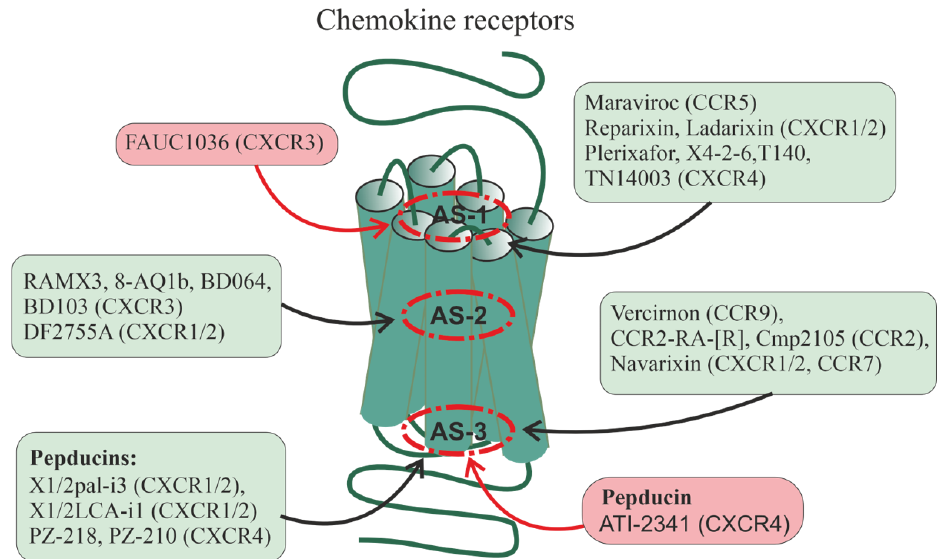
Figure 2. Allosteric regulation of chemokine receptors. There are data on the allosteric regulation of a significant number of chemokine receptors, including CXCR1, CXCR2, CXCR3, CXCR4, CCR2, CCR5, CCR7, and CCR9. Allosteric sites in them can be located at different loci of the TMD: in the upper (outwardly oriented) portion of the transmembrane tunnel (interfaces including the membrane- proximal segments of ECLs and extracellular segments of TMs, as well as the outer vestibule of the transmembrane channel) (designated as AS-1), in the central part of the 7TM bundle (AS-2), and in the lower (oriented to the cytoplasm) portion of the transmembrane tunnel (interfaces, including the membrane-proximal segments of ICLs and the cytoplasmic endings of TMs) (AS-3). In each of these loci, there are several cavities in which allosteric sites can be located, both overlapping and spatially separated. Along with this, allosteric sites can be located in hydrophilic loops being targets for autoantibodies and synthetic pepducins. Endogenous allosteric regulators of the chemokine receptors are sodium (NAM) and zinc (PAM) ions, as well as cholesterol and membrane phospholipids (mainly with PAM activity). Synthetic small allosteric regulators interact with allosteric sites located at all three loci, AS-1, AS-2, and AS-3, while pepducins, lipidated derivatives of peptides corresponding to ICLs, are transported across the plasma membrane and interact with intracellular sites. Figure 2 shows the following small regulators interacting with the AS-1 locus: maraviroc (CCR5-selective NAM), reparixin, ladarixin and their analogs (CXCR1/CXCR2-selective NAMs and/or non-competitive allosteric antagonists), plerixafor (allosteric CXCR4-inhibitor), FAUC1036 (biased allosteric CXCR3-agonist), T140 and its analog TN14003 (biased allosteric CXCR4-antagonists), and the peptide X4-2-6 (TM2/ECL1 of CXCR4; allosteric CXCR4-antagonist). The following ligands bind specifically to the AS-2 locus: RAMX3 and its biased analogs 8-azaquinazolinone (8-AQ) derivative 1b, BD064, and BD103 (CXCR3-selective NAMs), DF2755A (noncompetitive allosteric CXCR1/CXCR2-antagonist). The following ligands bind specifically to the AS-3 locus: vercirnon and its analogs (allosteric CCR9-antagonists), navarixin (allosteric antagonist of CXCR1, CXCR2 and CCR7), CCR2-RA-[R] and Cmp2105 (allosteric CCR2-antagonists and/or NAMs). Pepducins, such as N -palmitoylated peptides X1/2pal-i3 (ICL3 of CXCR1/CXCR2;